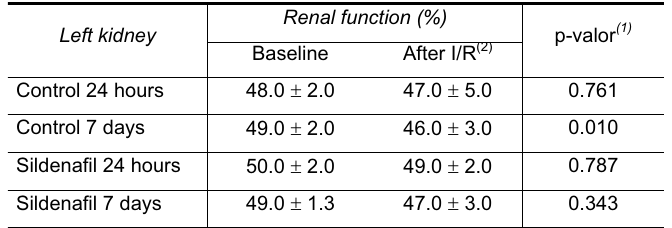
TABLE 2 - Descriptive data (pixels) of differential renal function defined by scintigraphy, using Kodak Molecular Imaging Software